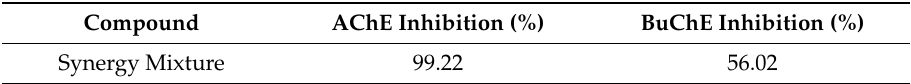
Table 13. Synergy mixture cholinesterase inhibition comparison: the synergy mixture was much more e ff ective at inhibiting AChE although relevant inhibition of BuChE was still